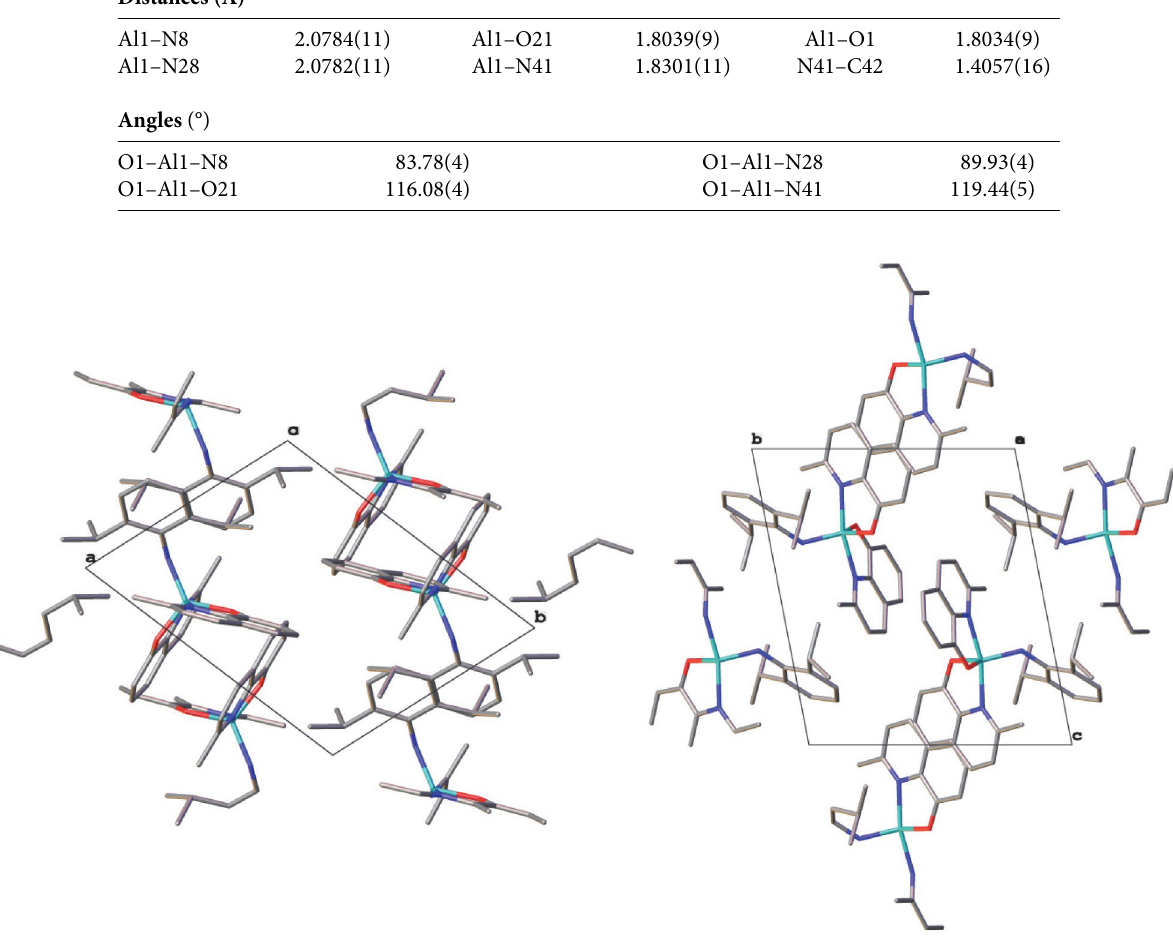
Figure 4. Packing in the unit cell of 3 , viewed along c -crystallographic axis (left) and a -crystallographic axis (right), hydrogen atoms were omitted for clarity